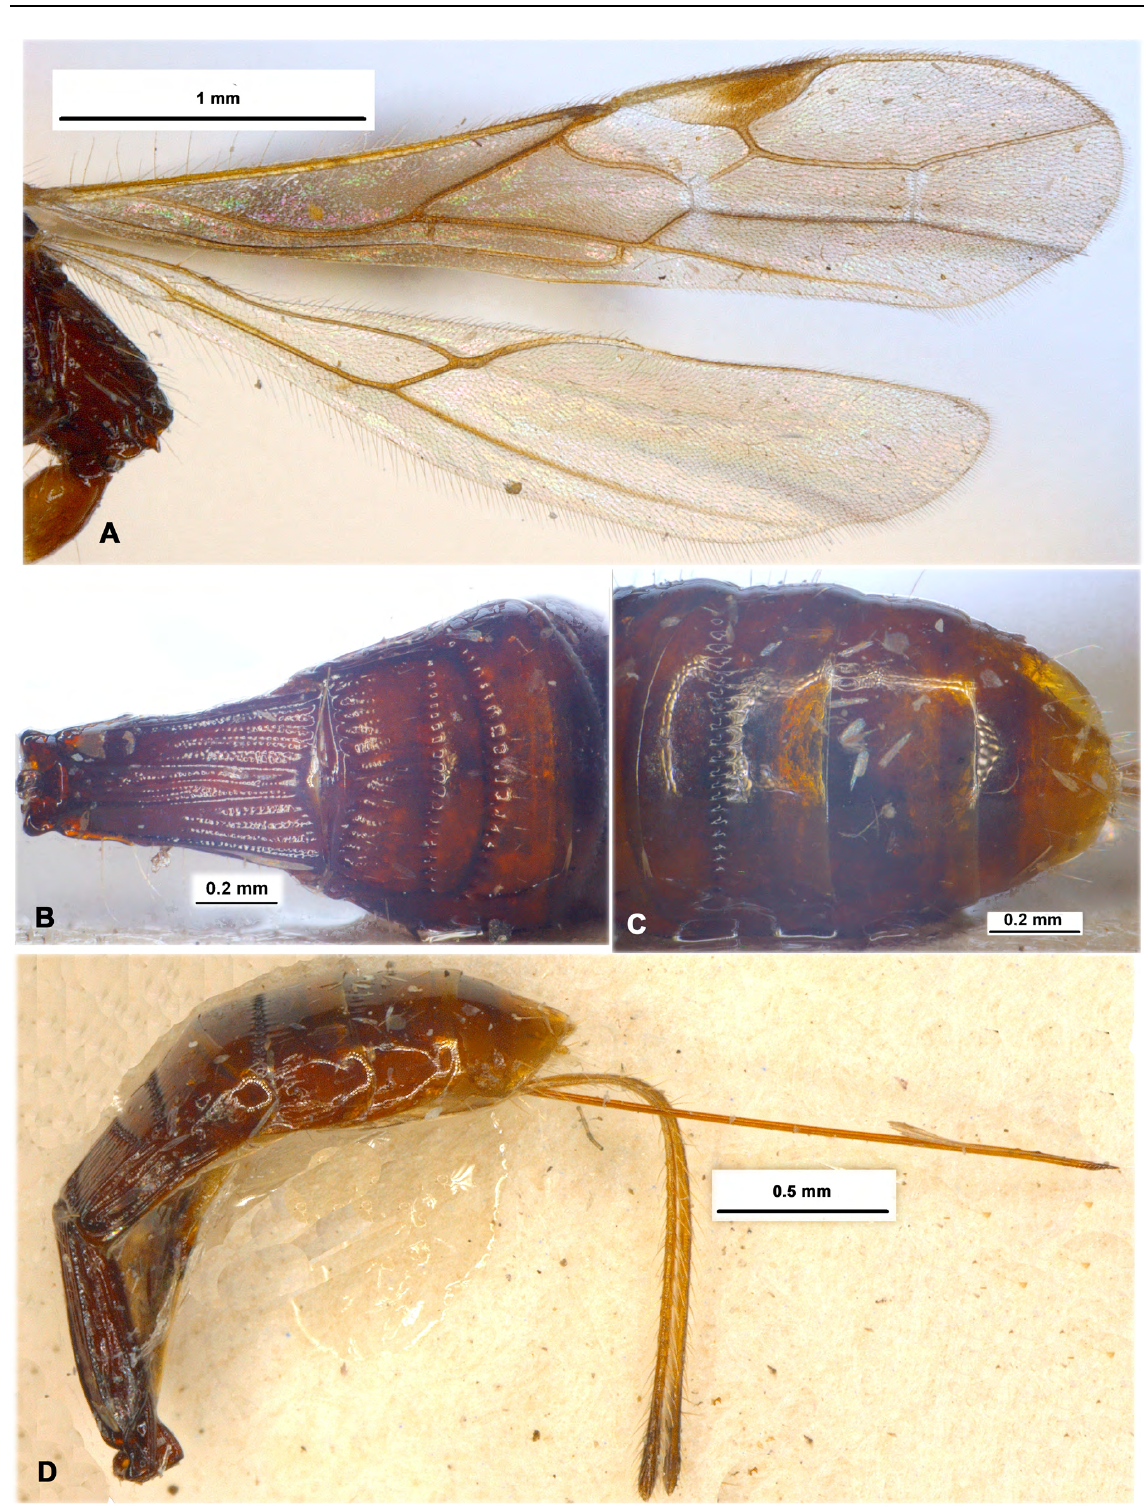
Fig. 17. Ipodoryctes ( Afroipodoryctes ) insignis (Granger, 1949), ♀, holotype, MNHM. A . Wings. B . First to third metasomal tergites, dorsal view. C . Apical metasomal tergites, dorsal view. D . Metasoma and ovipositor, lateral